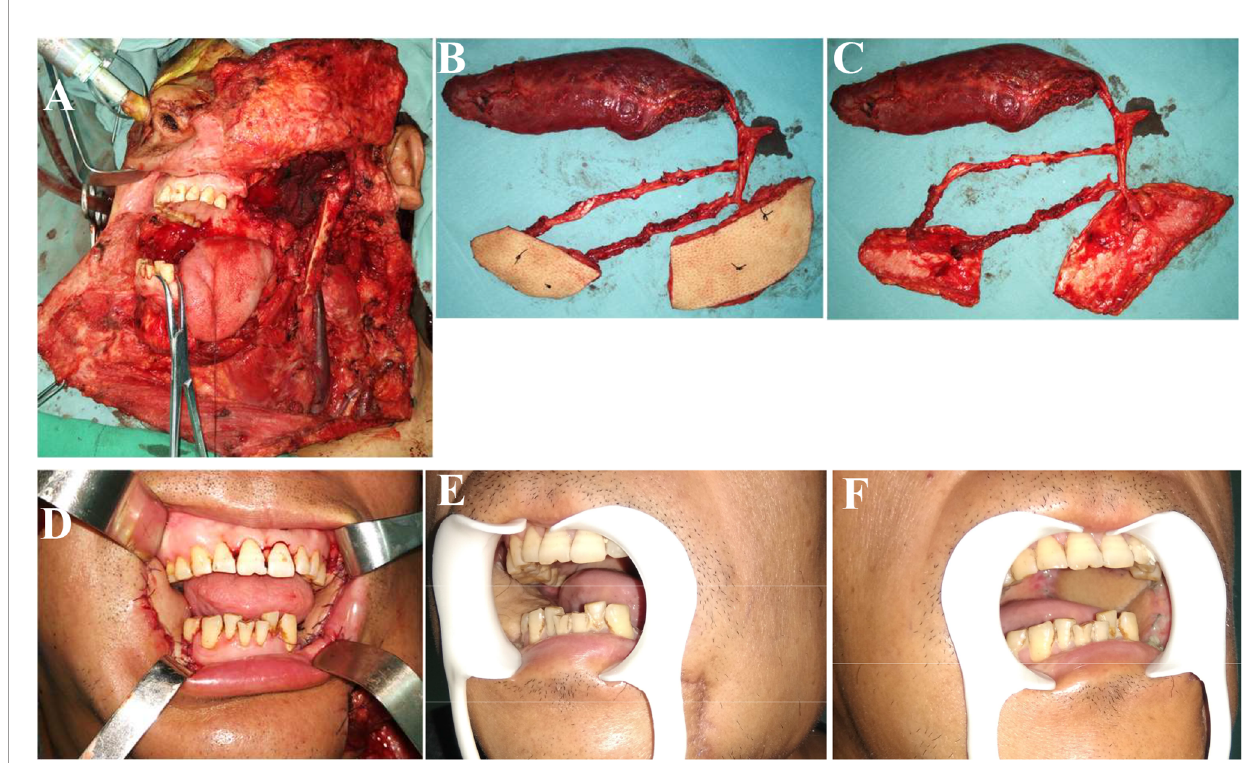
FIGURE 1 | Reconstruction of complex bilateral buccal mucosal defects (involving the lateral skull base) using ALT chimeric fl aps. (A) Left lateral skull base defects and right buccal mucosal defects resulting from bilateral buccal squamous cell carcinoma resection. (B, C) Chimeric ALT, ALT, and rectus femoris fl aps (entire rectus femoris). (D) Reconstruction of complex defects using ALT chimeric fl aps, separate fl aps for bilateral buccal mucosal reconstruction, and rectus femoris fl ap for lateral skull base dead space fi lling. (E, F) One month postoperatively. ALT, anterolateral